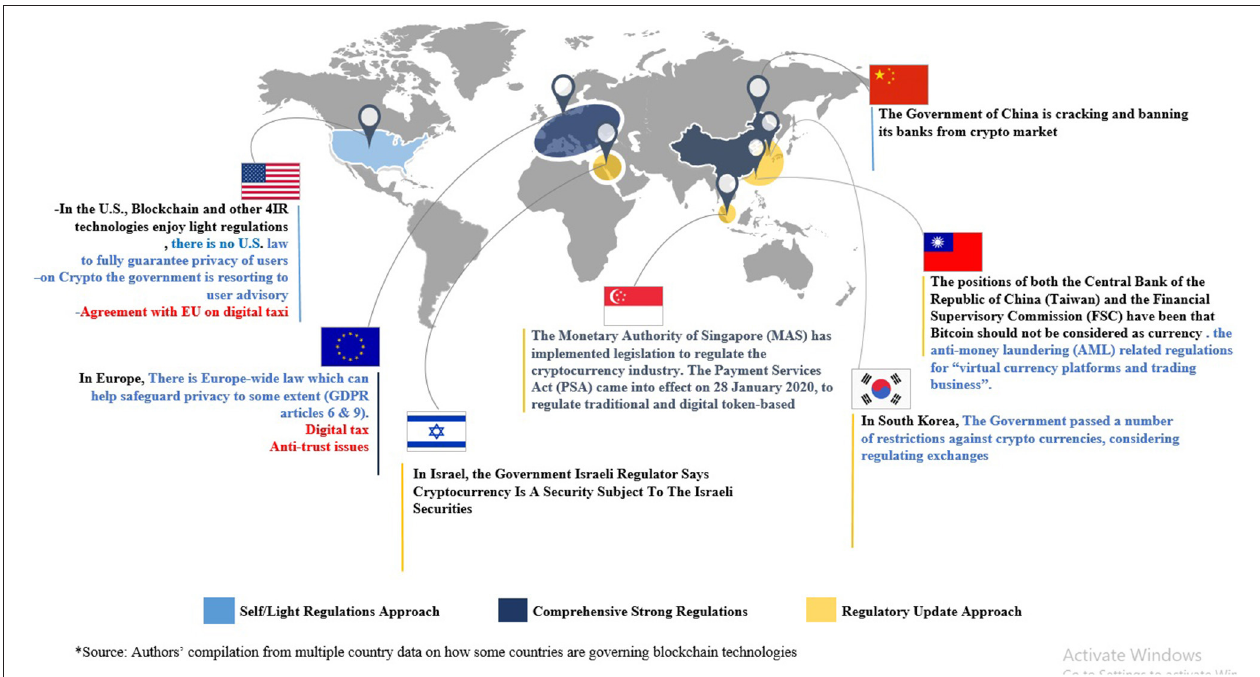
FIGURE 5 | Emerging technology governance ecosystem map of major